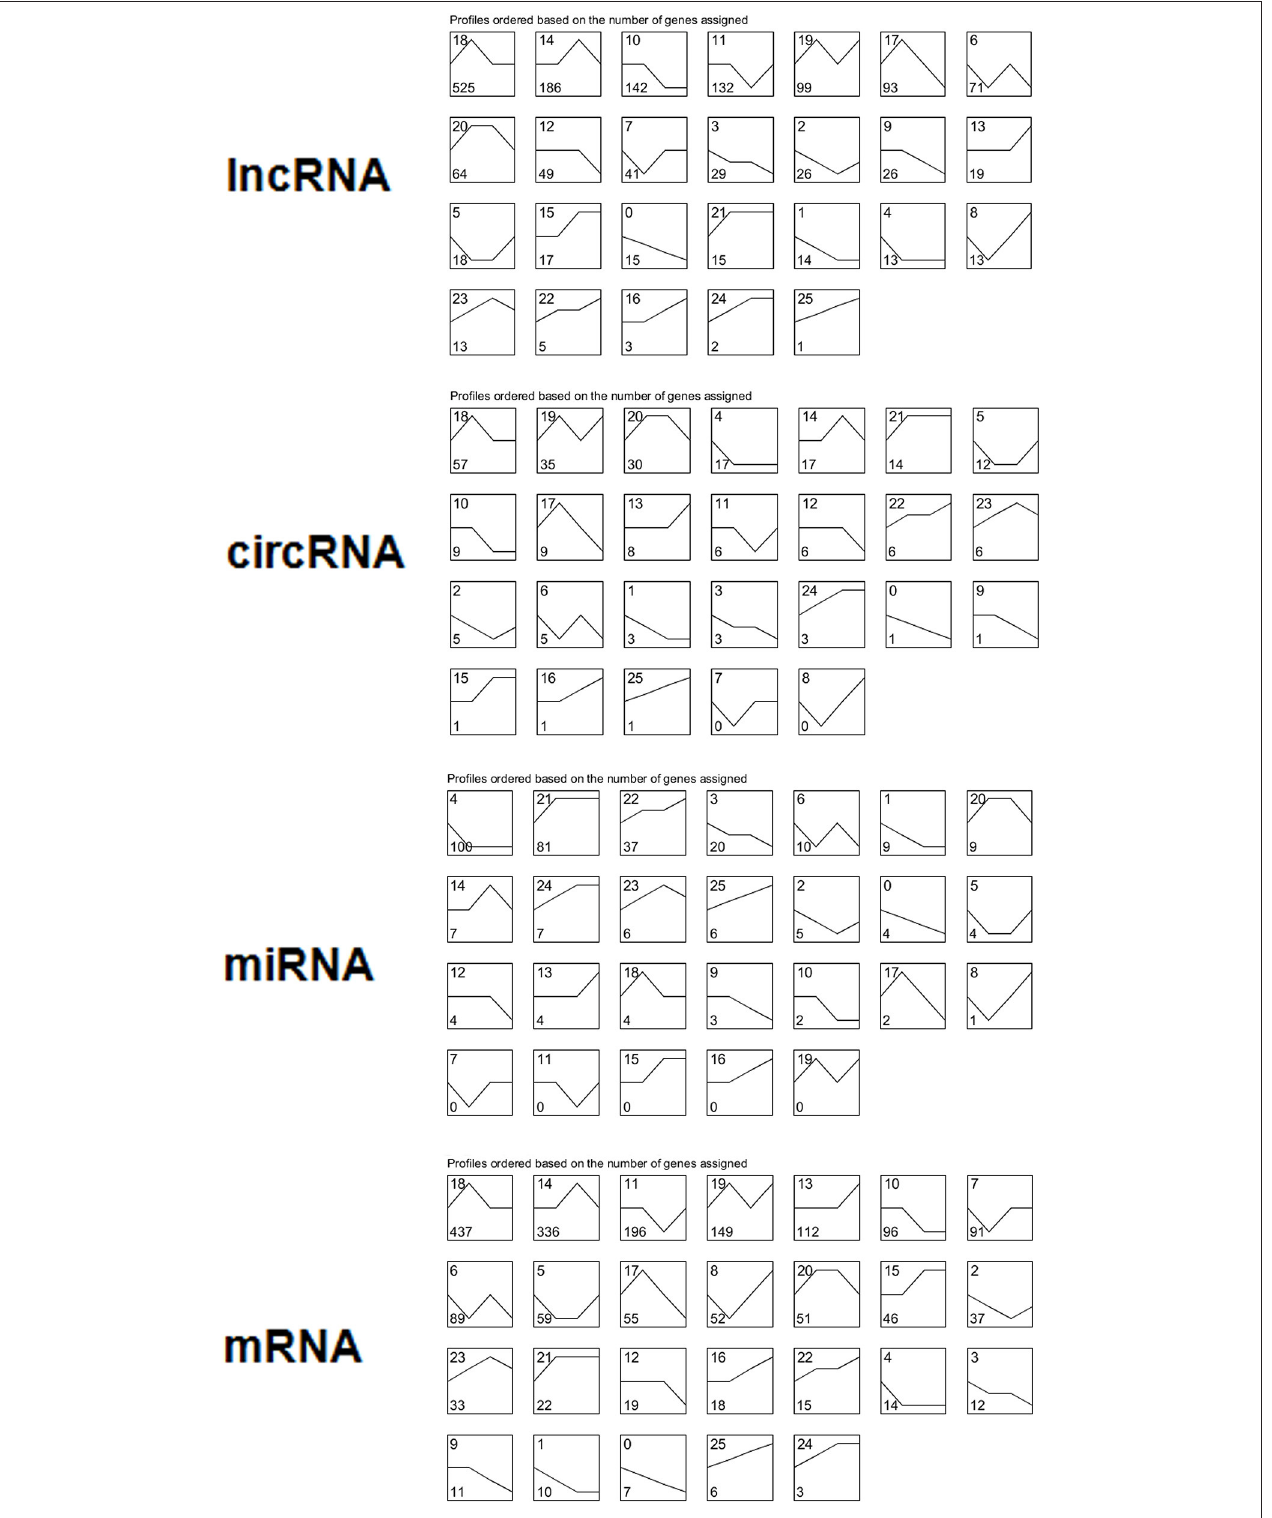
FIGURE 4 | Overall expression patterns of lncRNAs, circRNAs, miRNAs, and mRNAs. All 26 expression profiles obtained for four types of RNAs were identified by performing a series cluster analysis. In each small graph, the number at the top left represents the expression type, and the number at the bottom left represents the number of genes in each expression